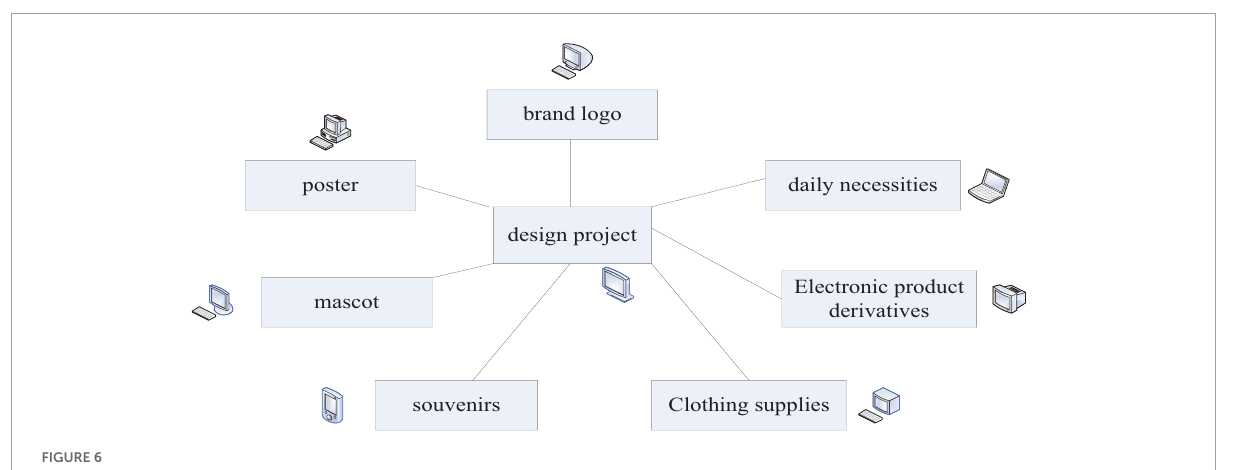
FIGURE6 Hakka culture brand image design